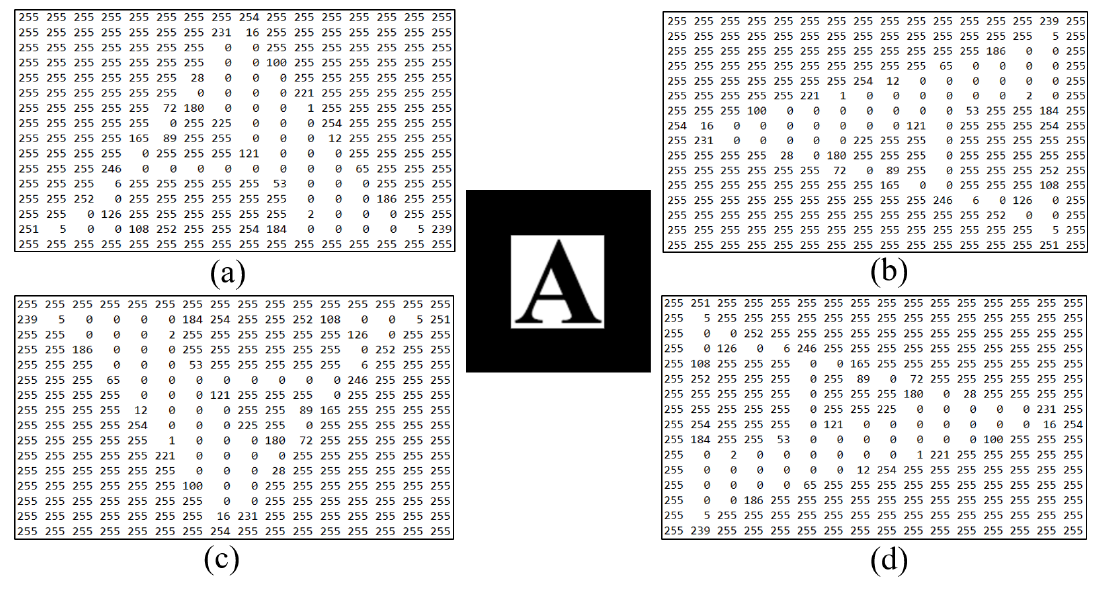
Figure 4. A marker (letter A) with four sample templates: ( a ) normal position, ( b ) rotate left, ( c ) rotate upside down, and ( d ) rotate